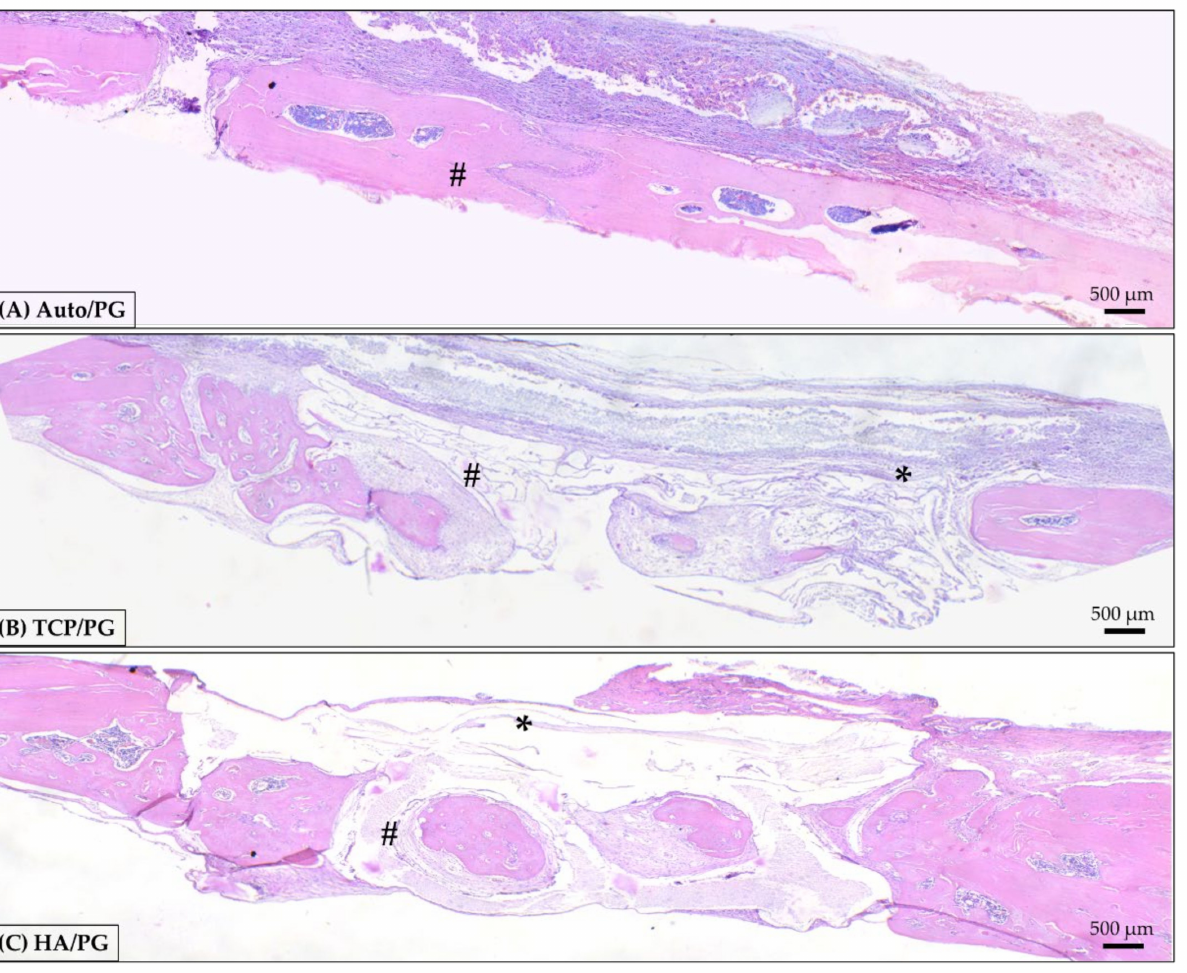
Figure 6. Representative photomicrographs of Auto/PG, TCP/PG, and HA/PG at 30 day histological analysis. ( A ): Auto/PG group; ( B ): TCP/PG group; ( C ): HA/PG group. Staining: Hematoxylin and eosin. Legend: * PDO membrane; # autogenous block and 3D-printed blocks. Scale bar: 500 µ m (4 ×